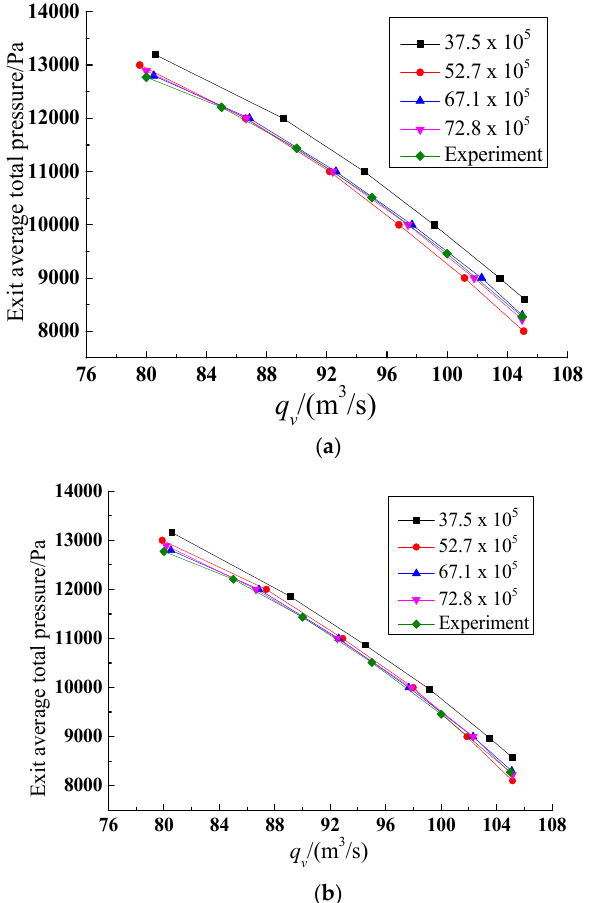
Figure 4. Grid independence calculation. ( a ) Grid independence calculation with multiple reference frames (MRF) technique; ( b ) Grid independence calculation with moving mesh technique.